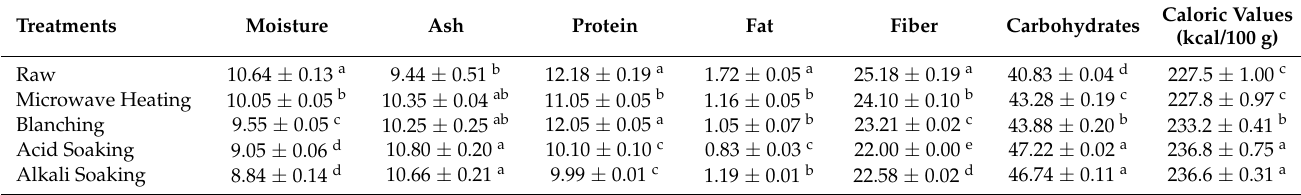
Table 2. Proximate composition of raw and processed cabbage powder (g/100 g).